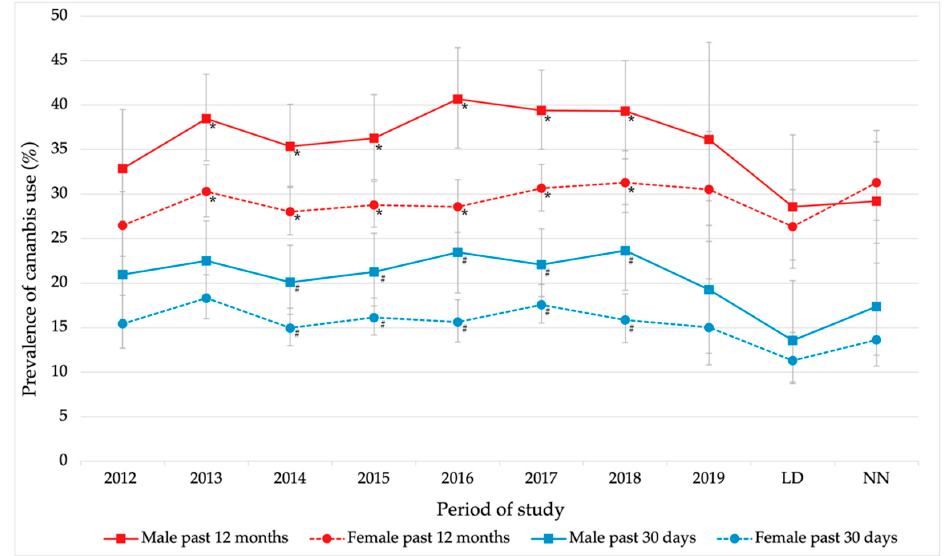
Figure 2. Evolution of the prevalence of cannabis use (%) in university students, past 12 months and past 30 days, by sex. Error bars show a 95% confidence interval on the prevalence rates. * p < 0.05 Male vs. Female (past 12 months); # p < 0.05 Male vs. Female (past 30 days).